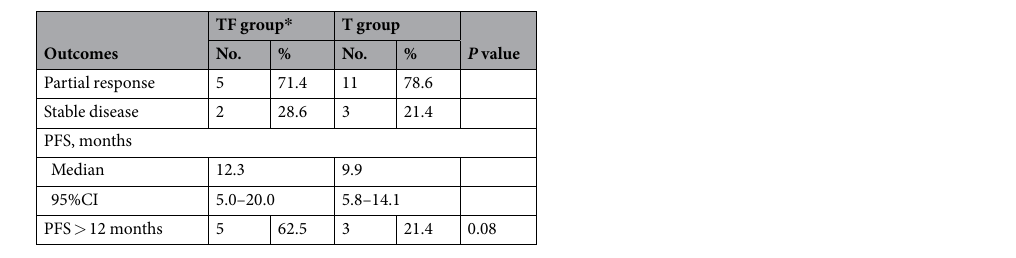
Table 2. Main clinical outcomes. * Included 7 patients with evaluable responses.